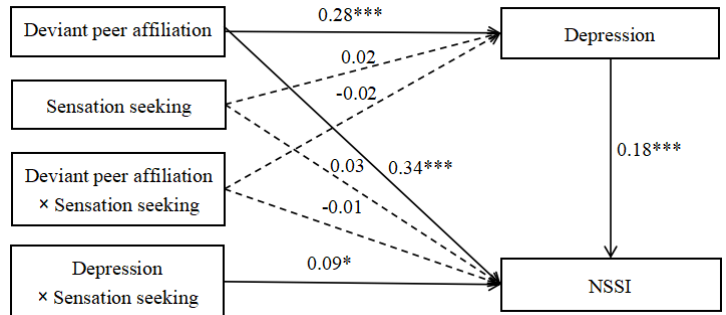
Figure 3. Model of the moderating role of sensation seeking on the indirect relationship between deviant peer affiliation and NSSI, Note: The numbers are standardized regression coefficients. Path coefficients between control variables (gender and age) and each of the variables in the model are not displayed. Of those paths, gender was significantly associated with depression ( b = − 0.15, SE = 0.04, t = − 4.09, p < 0.001). NSSI = non−suicidal self− injury. * p < 0.05; *** p < 0.001.